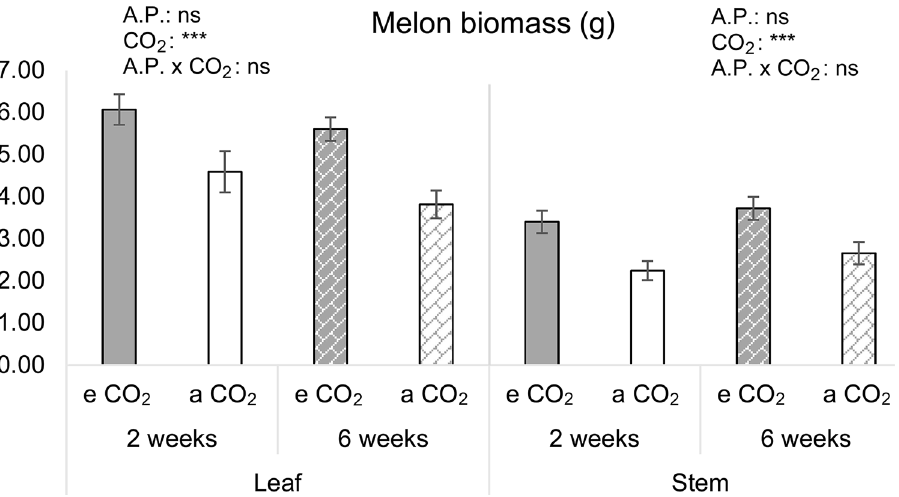
Figure 2. Melon biomass. Dry weight of leaves and stems of melon plants measured after a previous acclimation period (A.P.) to two or six weeks to elevated CO 2 (eCO 2 ) (700 ppm) or ambient CO 2 (aCO 2 ) (400 ppm). Mean values ± SE are shown (n = 10). ***(P ≤ 0.001) when statistically significant differences were found, ns (no significant differences) (Two-way ANOVA and LSD